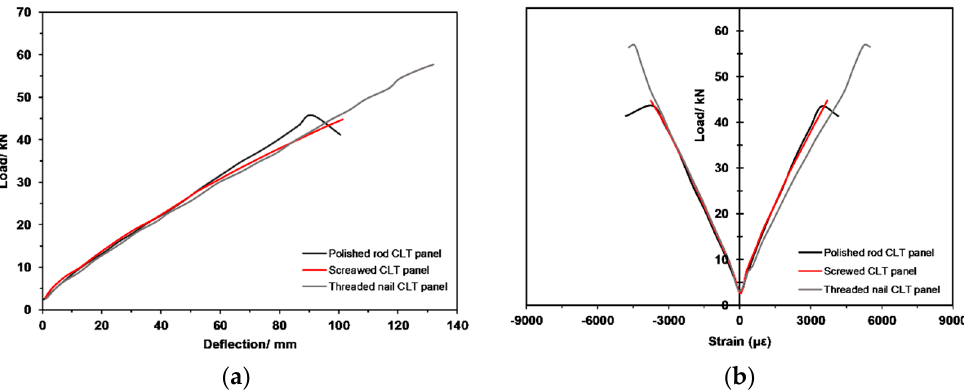
Figure 10. Effect of nail type on load ‐ deflection and load–strain relationship. ( a ) Load ‐ deflection curve; ( b ) Load–strain curve.